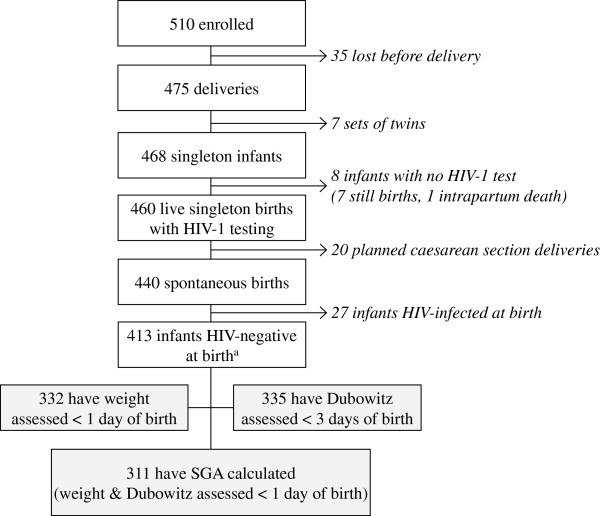
Patient flow chart.